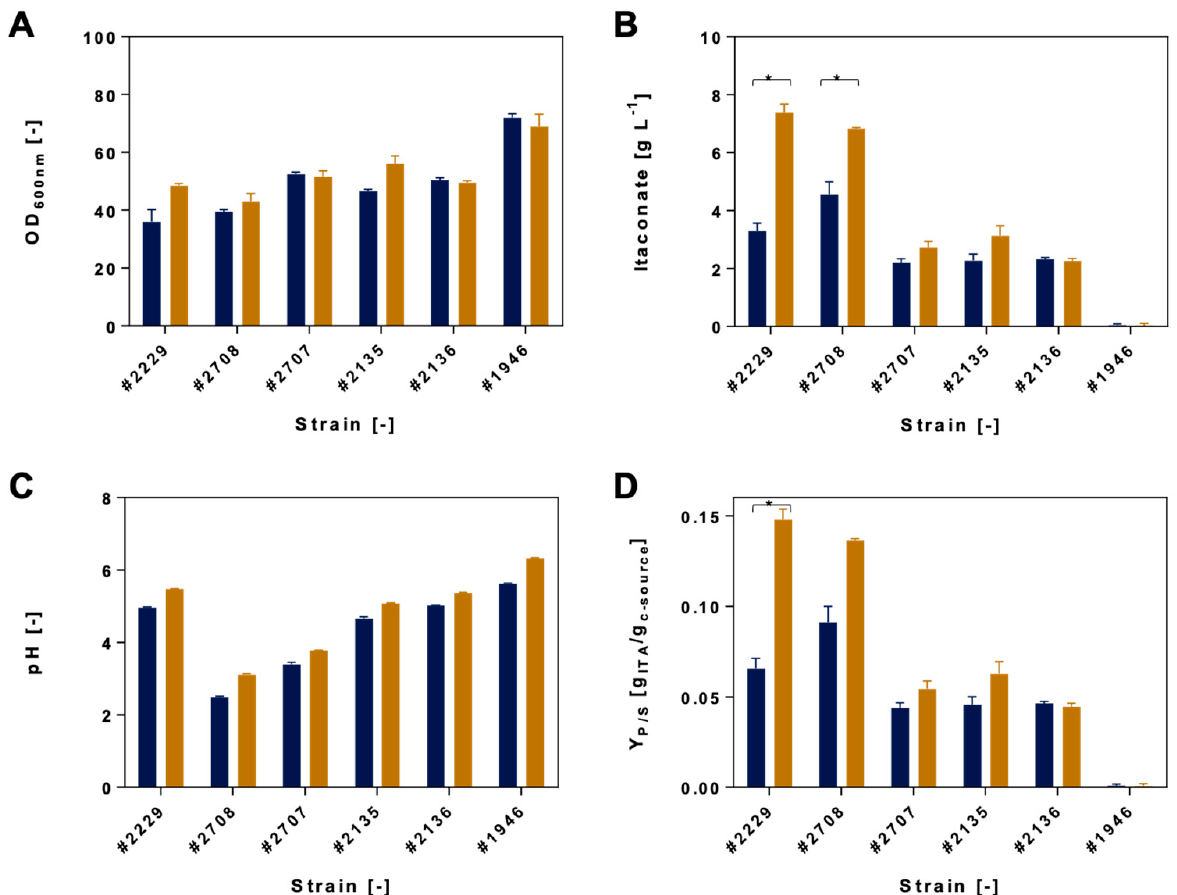
Figure 4. Itaconic acid production of selected Ustilaginaceae strains. ( A ) Maximum optical density (OD 600 [ − ]), ( B ) maxi- mum itaconic acid production [g L − 1 ], ( C ) minimum pH [ − ], and ( D ) Y P/S [g ITA /g c-source ] during System Duetz ® 24-deep-well plate cultivation experiments with 1.5 mL MTM medium and 0.8 g L − 1 NH 4 Cl. Ustilaginaceae candidates using acetate as a co-substrate are shown in orange (6.25 g L − 1 ). Respective glucose references (50 g L − 1 ) are shown in blue. Error bars indicate the deviation from the mean for n = 2. Statistically significant differences in itaconic acid production ( p ≤ 0.05) are indicated as * . Details of statistical analyses are displayed in Tables S11 and